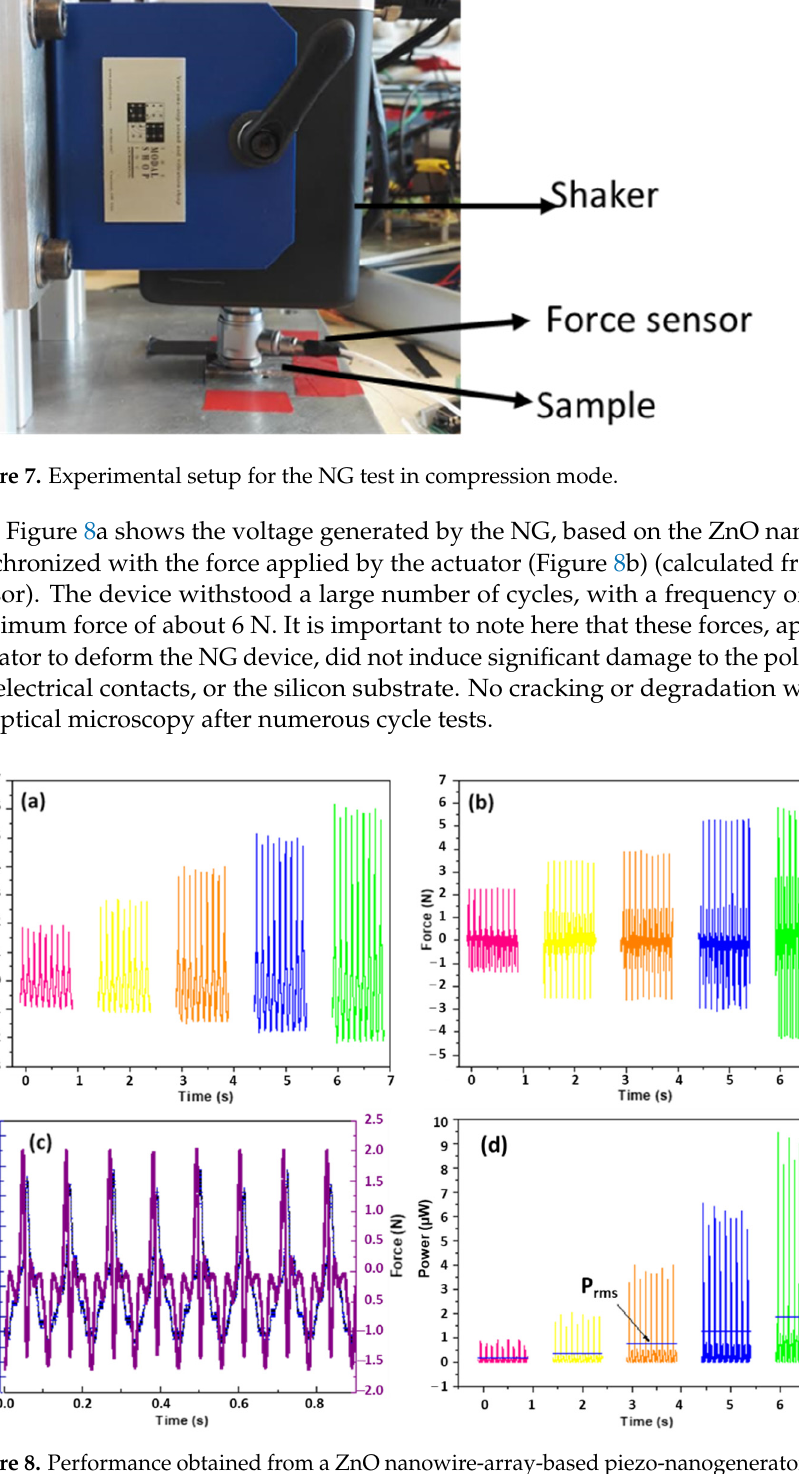
Figure 8. Performance obtained from a ZnO nanowire-array-based piezo-nanogenerator. ( a ) Potential generated under a compressive force. ( b ) Corresponding forces applied on the NG. ( c ) A zoom on the applied force. ( d ) Power obtained from NG under different applied forces.